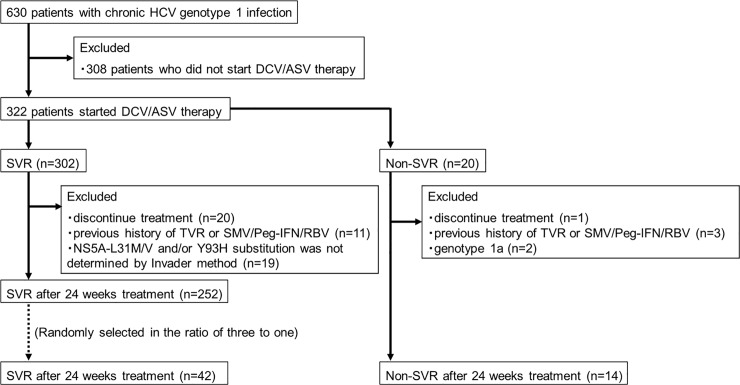
Flow chart of all enrolled patients.